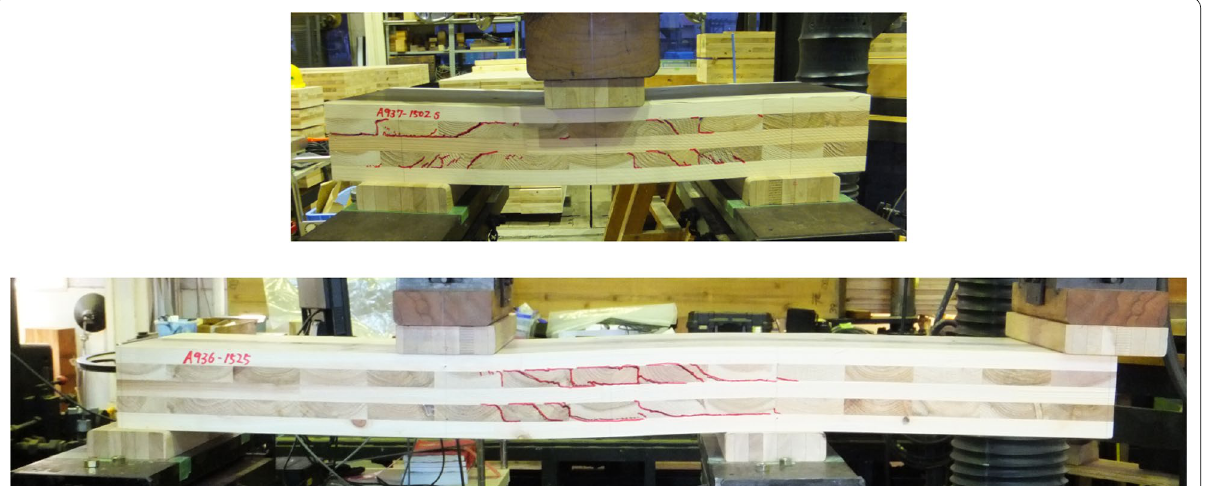
Fig. 3 Typical rolling shear failure observed in the three-point and asymmetric four-point bending tests